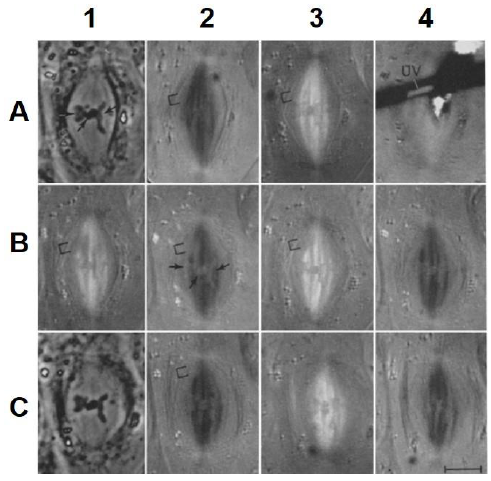
Figure 19. A crane fly spermatocyte irradiated during metaphase. ( A1 ) autosomes labeled with arrow; ( A2 , A3 ) the position to be irradiated is indicated by a bracket; ( A4 ) UV = the ultraviolet irradiation; ( B1 , B2 , B3 , C2 ) The position of the area of reduced birefringence (on the chromosomal fiber of the left bivalent) is indicated by a bracket; ( B2 ) the autosomes labeled with arrows. The times of